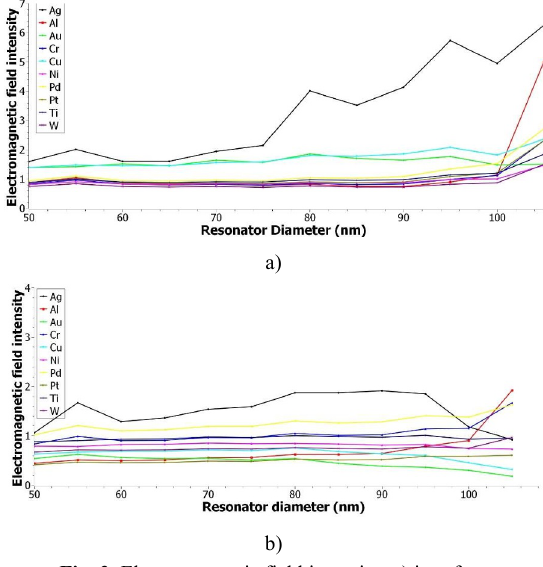
Fig. 3. Electromagnetic field intensity: a) interface medium/resonators; b) interface resonators/substrate. Fig 2. The elementary cell through which can be obtained a metasurfaces with U-shape nanostructures of variable dimensions by translation in the two directions x and y . The propagation direction of the electromagnetic radiation is the z direction.